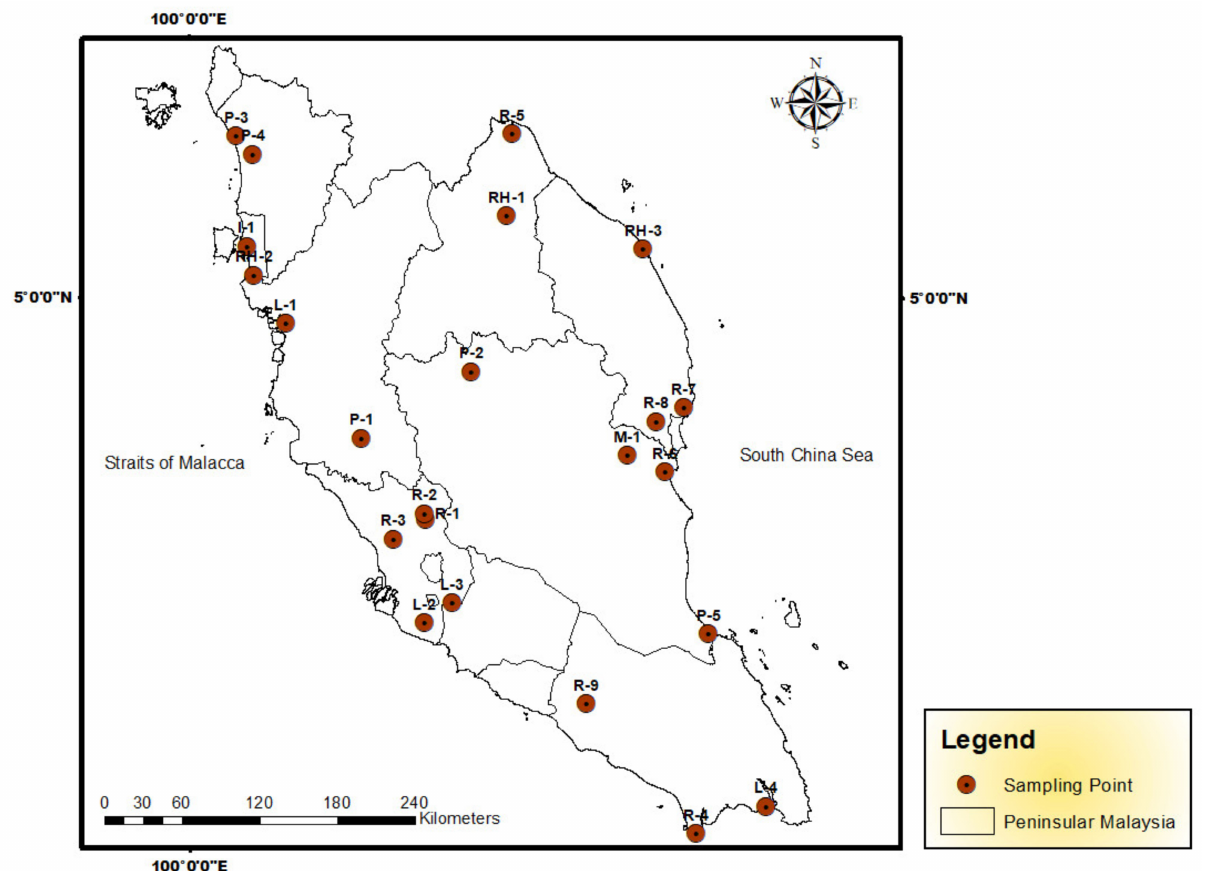
Figure 1. Sampling sites in Peninsular Malaysia (Numbers of sampling sites are described in Table